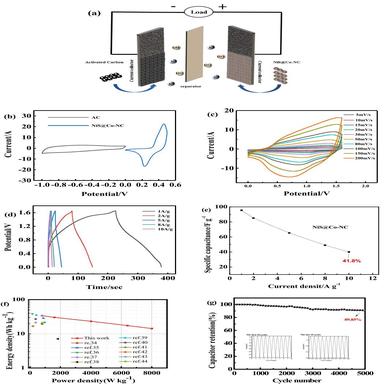
Electrochemical performance of aqueous NiS@Co-NC //AC HSC measured in 6 M KOH solution: (a) Schematic diagram of assembled aqueous hybrid device; (b) The CV curves of the asymmetric supercapacitor anode and cathode materials at 50 mV⋅s − 1 under a three-electrode system; (c) CV curves for NiS@Co-NC//AC HSC from 5 mV⋅s − 1 to 200 mV⋅s − 1 ; (d) GCD curves of NiS@Co-NC//AC HSC at various current densities; (e) The relationship between energy density and power density at different currents; (f) Ragone plot of